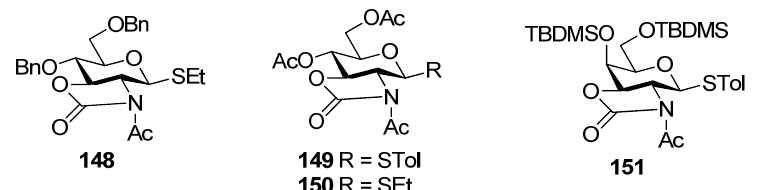
Figure 4. N -Acetyl 2,3- trans -oxazolidinone-protected donors 148-151